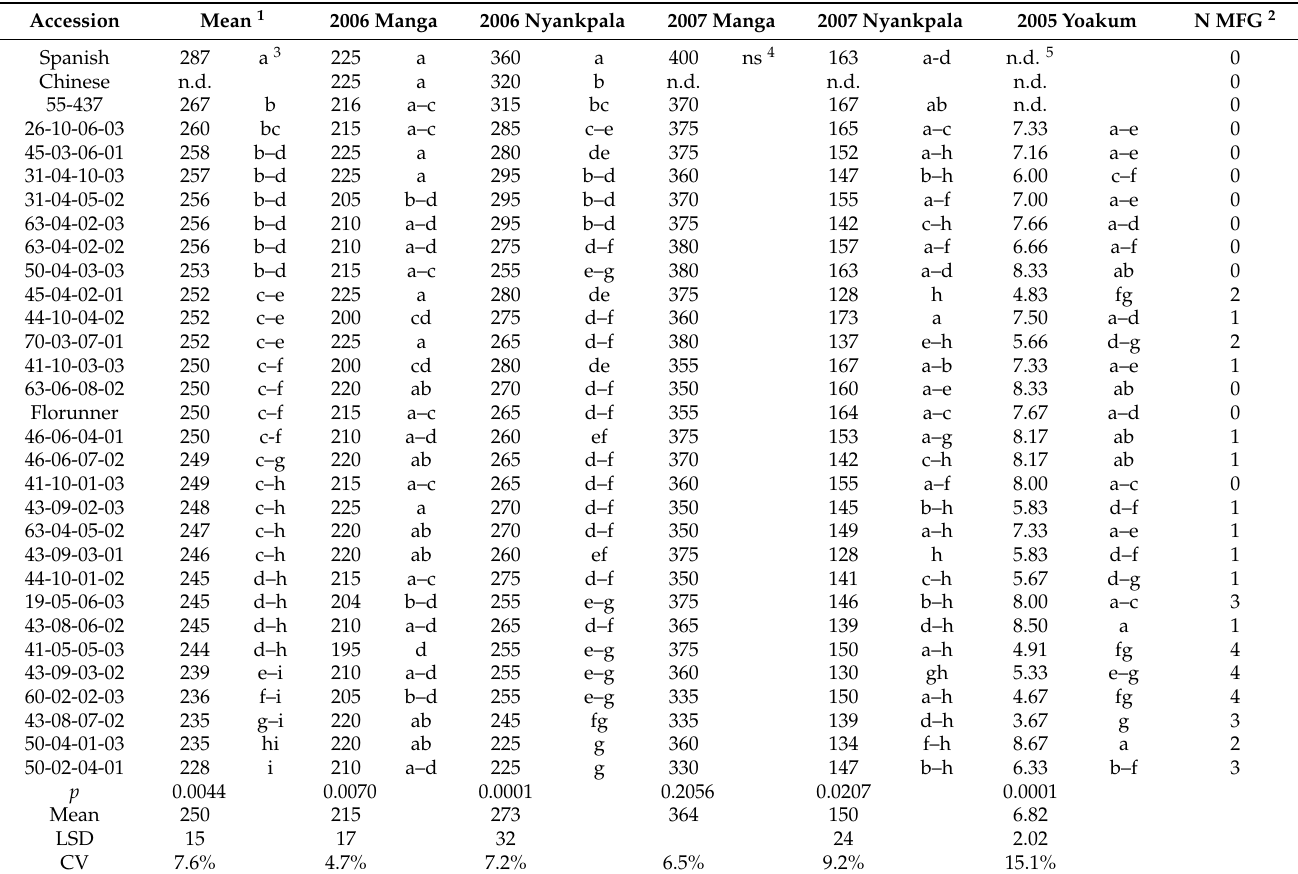
Table 1. Response of cultivars to early leaf spot at five environments. Values are AUDPC scores for Manga and Nyankpala in Ghana, and Florida scale score for Yoakum, TX in the